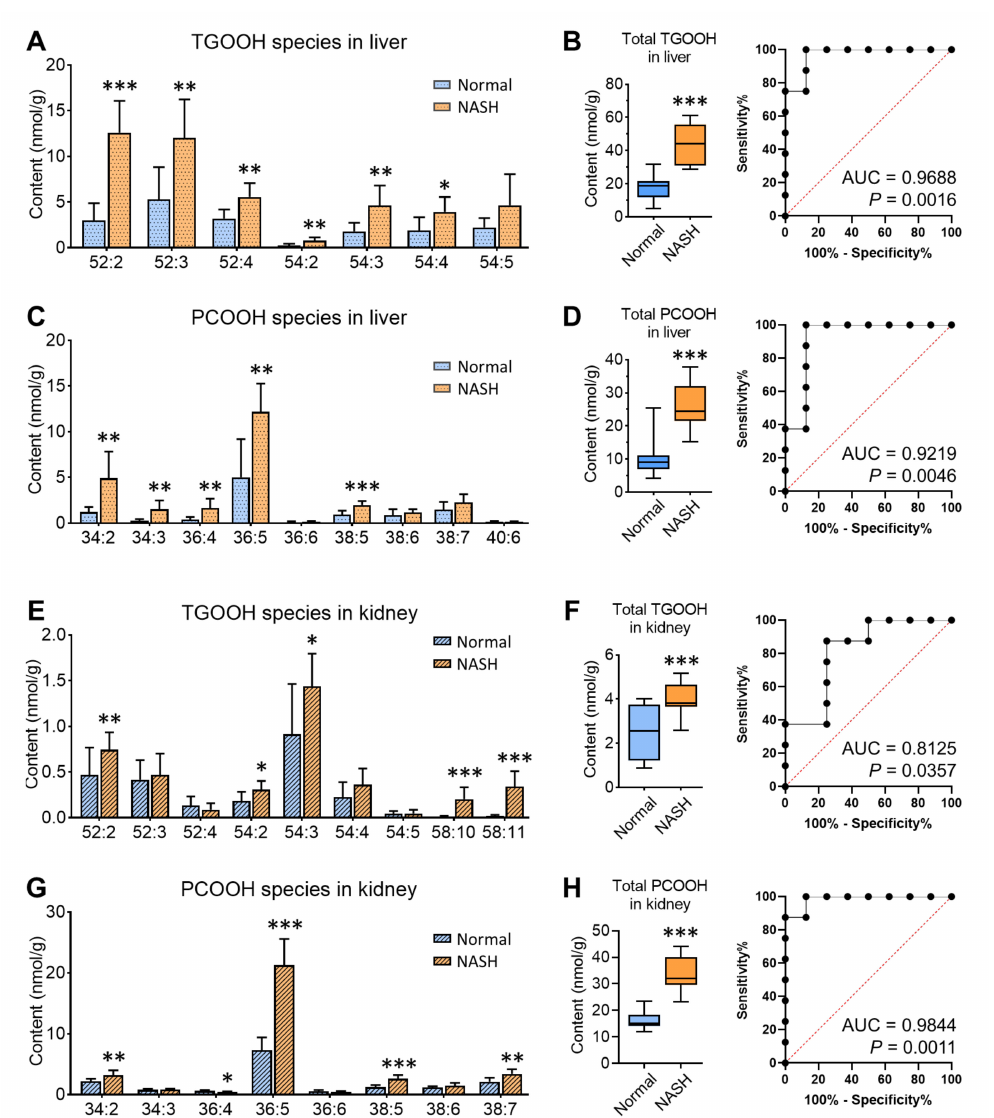
Figure 5. Accumulation of lipid hydroperoxides in NASH model mice. ( A ) TGOOH species in the liver. ( B ) Comparison and the ROC curve of the total TGOOH in the liver. ( C ) PCOOH species in the liver. ( D ) Comparison and the ROC curve of the total PCOOH in the liver. ( E ) TGOOH species in the kidney. ( F ) Comparison and the ROC curve of the total TGOOH in the kidney. ( G ) PCOOH species in the kidney. ( H ) Comparison and the ROC curve of the total PCOOH in the kidney. * p < 0.05, ** p < 0.01, *** p < 0.001 vs. normal, calculated by two-tailed t